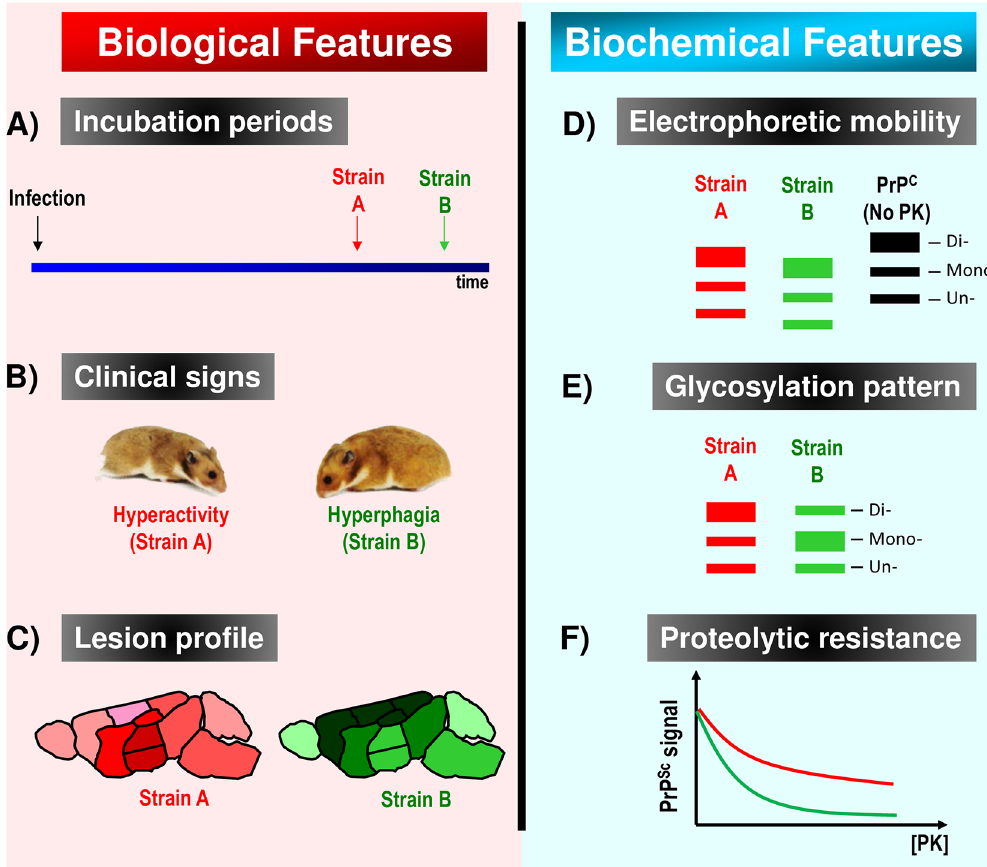
Fig 1. Differential biological and biochemical featuresused to distinguish between prion strains. (A) Incubationperiods to diseaseare one of main features allowingdifferentiation between prion isolates. Time differences betweenthe incubation periods of 2 prion strains may vary depending on the route of administration. (B) Different clinicalmanifestations may also help to discriminate betweendifferent prion agents. This propertyhas been very useful in some species (including goats and hamsters) but inefficient in others (such as mice). For example, signs as dissimilar as hyperactivityand hyperphagia can be observedwithin a single animal species(in this case, Syrian hamsters). (C) Prion isolates are known to inducespongiformdegeneration in different areas of the brain in a strain-specific manner. Recently, similar profileshave been adaptedfor the disease-associatedprion protein (PrP Sc ) deposition as well. In this graphicexample,darker color in certain brain areas represents more severe damage. (D) At the molecularlevel, the partial proteolyticresistanceof PrP Sc lies in its C-terminal region. Strain-specific prion folding is thought to protect different lengthsof the polypeptide chain from proteases, leadingto different electrophoretic mobilities. In this western blot model, no–Proteinase K treated cellularprion protein (PrP C ) is shown as comparison(black). (E) The ability of certain prion arrangementsto recruit specific PrP glycoforms also helps with easy strain characterizationby western blots. (F) Resistance to proteolytic degradation by increasing the concentration of proteases is commonly used to investigatethe identity of putativelydifferent prion isolates.